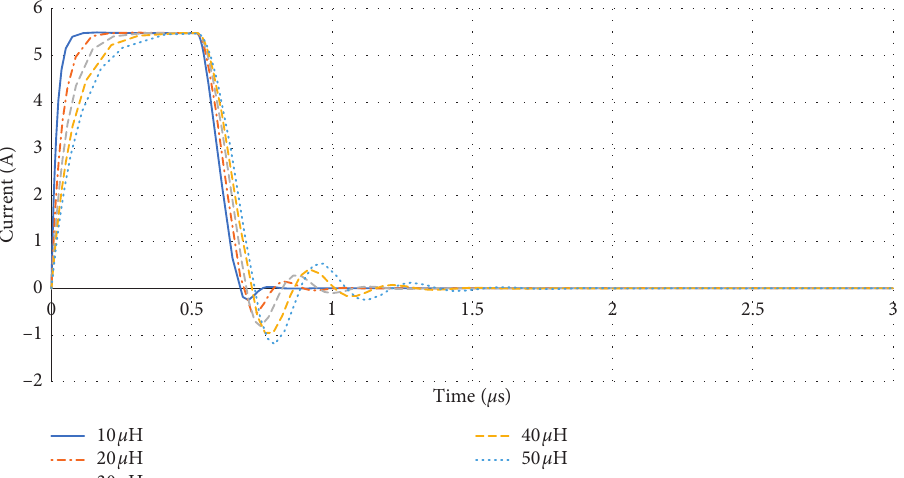
Figure 7: The effect of L